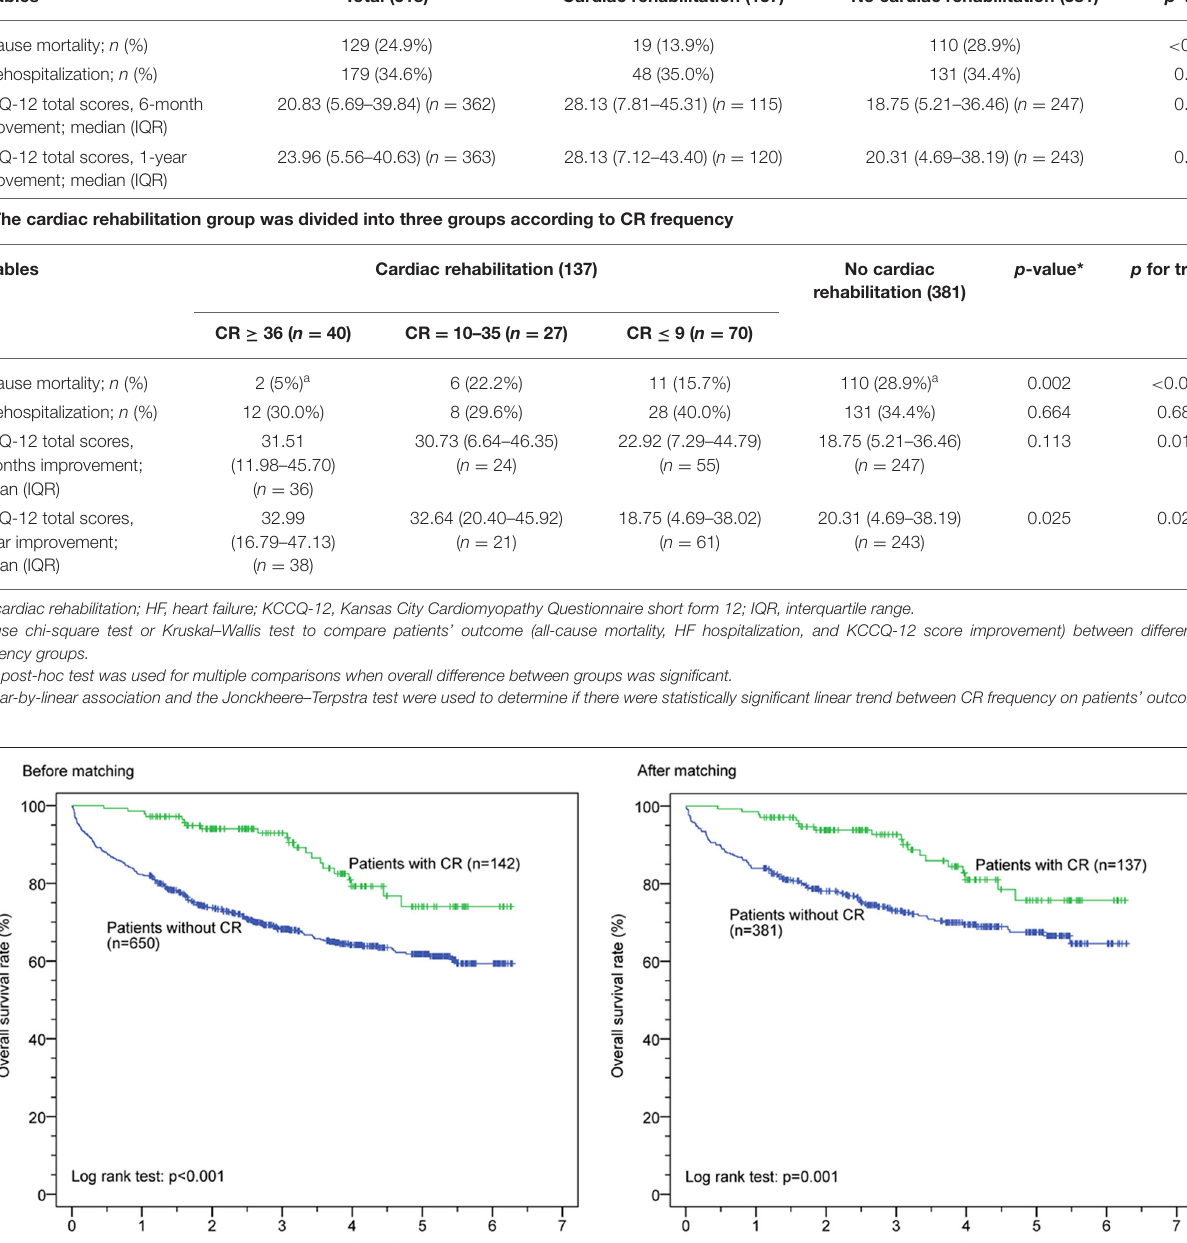
transitional, tailored, progressive rehabilitation intervention than usual care (14). As such, the medium- to long-term survival benefits of an earlier enrollment of patients (i.e., just discharged